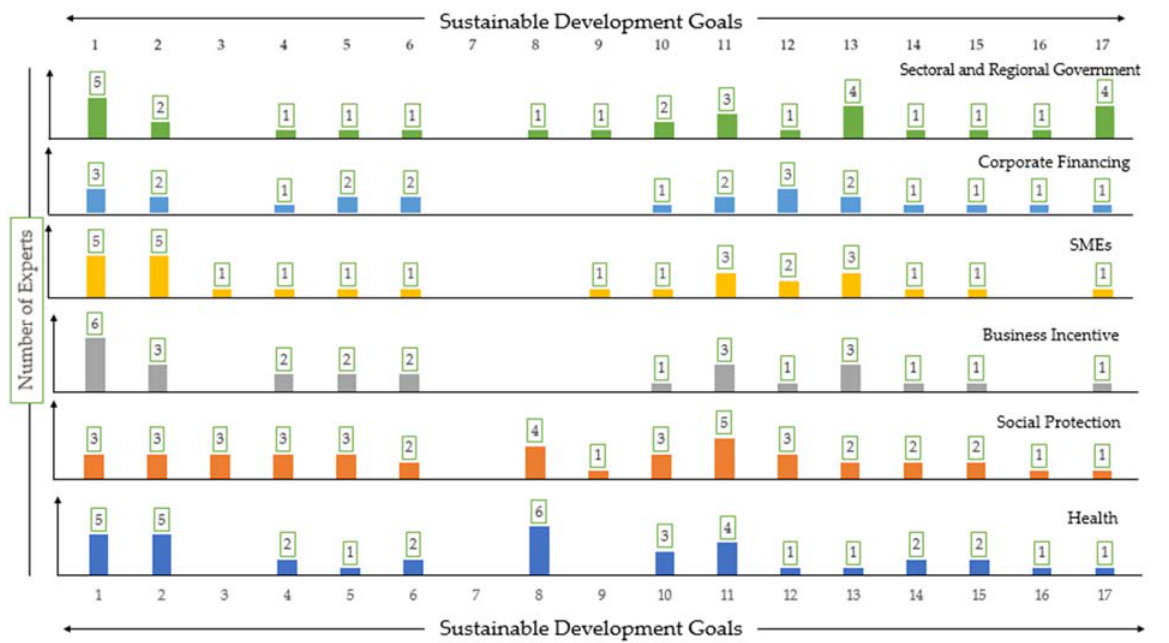
Figure 8. Perceived indirect impact of fiscal measures on SDG progress in Indonesia.